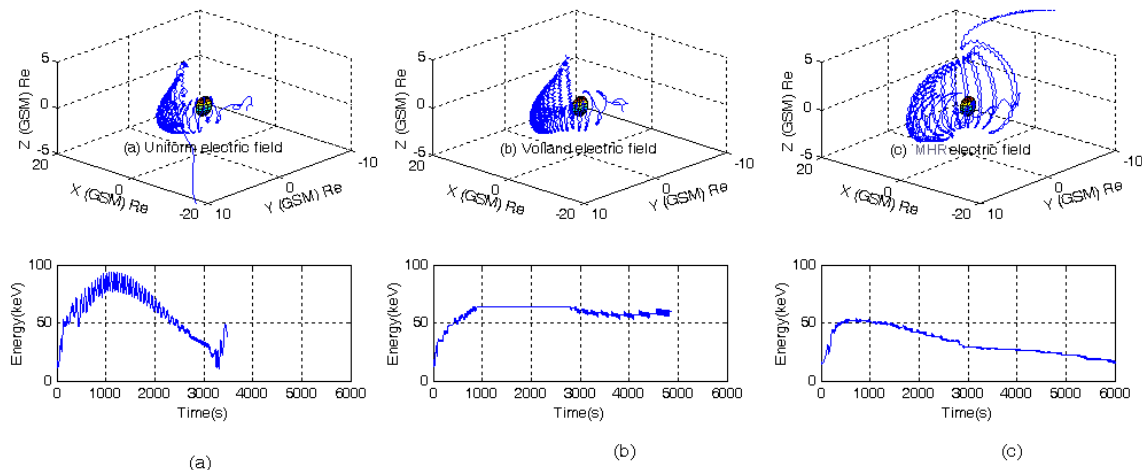
Fig. 5. Three drift trajectories of 15keV O + with an equatorial pitch angle of 60 ◦ initially situated at x =− 8 R E , y =− 2 R E and z = 0 and the energization process for the case corresponding to the Uniform, Volland and MHR electric fields in the T96 D st =− 100nT magnetic field model.